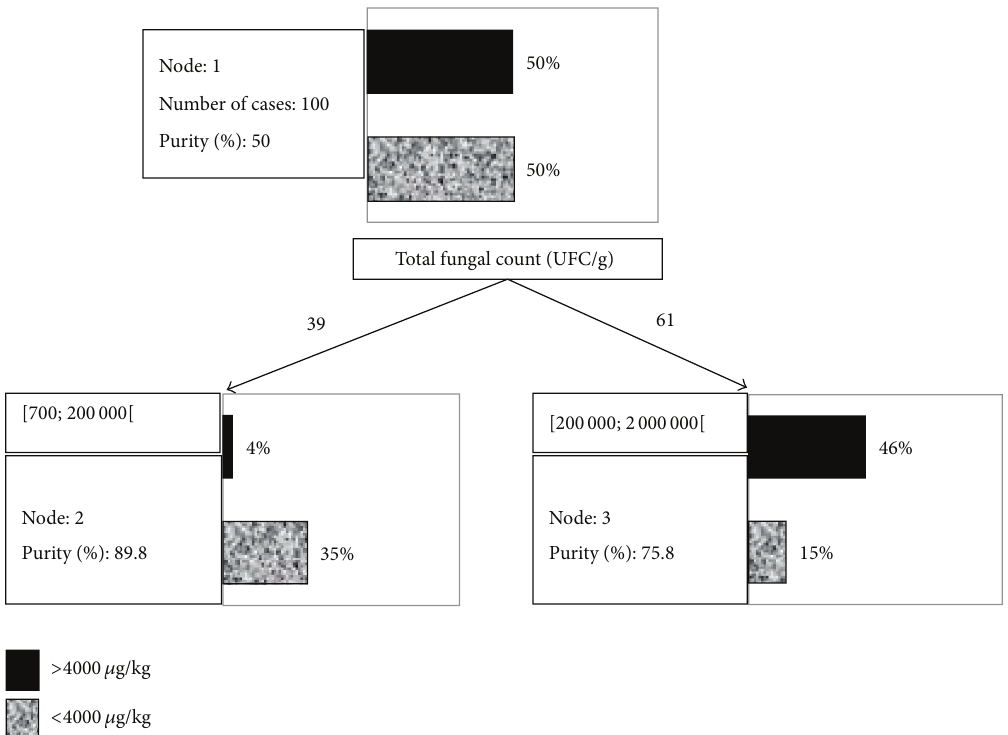
Figure 4: Binary decision tree obtained to predict fumonisin content (greater than or less than 4000 𝜇 g/kg) from ergosterol content and fungal count.